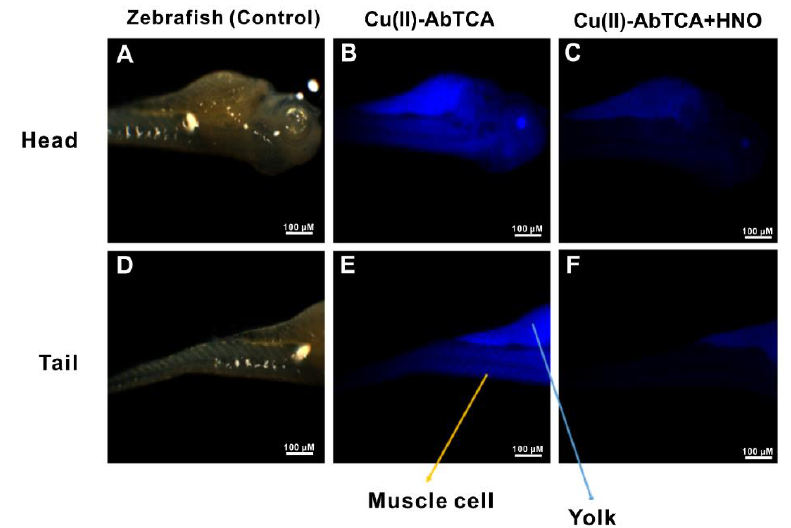
Figure 4. Fluorescence images of zebrafish. Head and tail portions of zebrafish alone (control) ( A , D ) zebrafish treated with Cu(II)-AbTCA (20 µ M) for 40 min ( B , E ); zebrafish treated with Cu(II)-AbTCA (20 µ M) for 40 min followed by addition of Angeli’s salt (200 µ M) for 10 min ( C , F ).